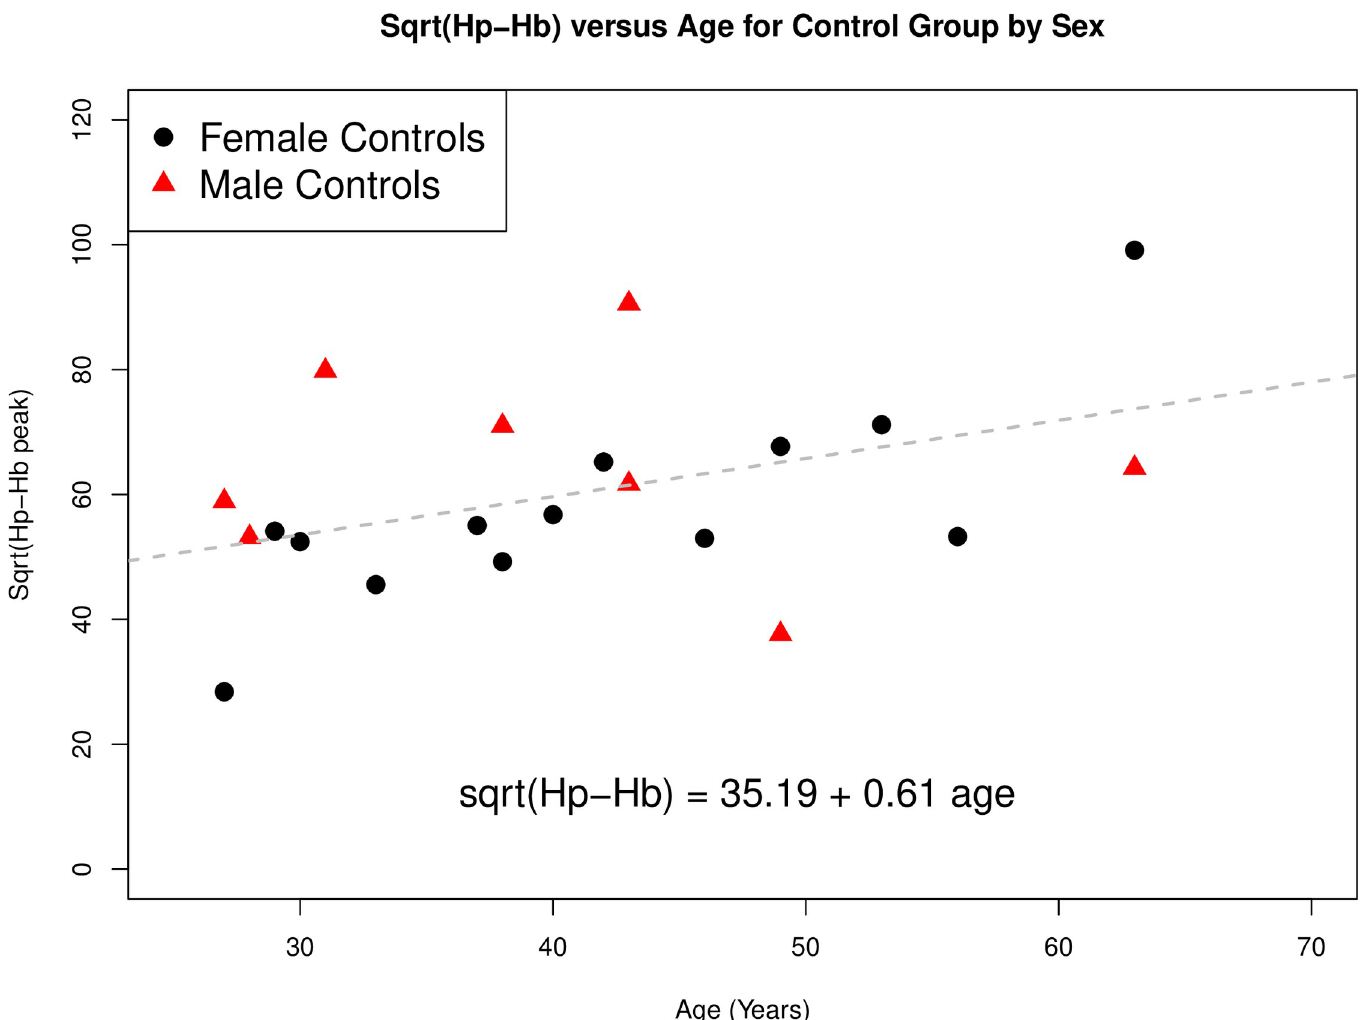
Fig 3. Plot of the age of the control participants (x-axis) against the square root of the obtained Fe-peak areas corresponding to the Hp-Hb complex (y-axis). The regression line is for all controls (adjusted R 2 of 0.14, F(1,19) = 4.12, p = 0.057) and depicts a positive association between the age of the individual and the Hp-Hb peak